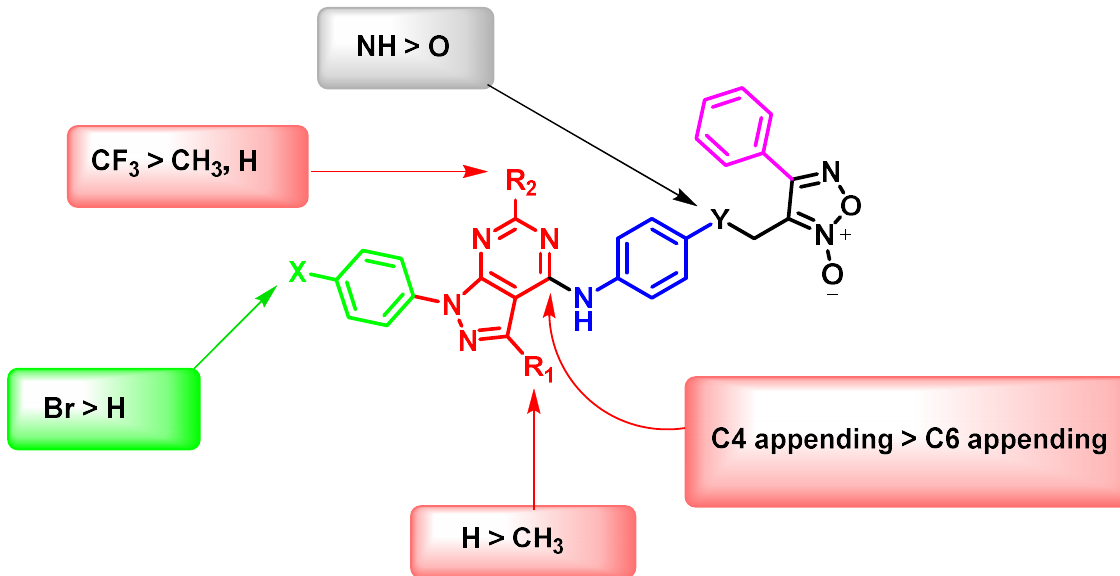
Figure 5. Preliminary SAR of target compounds.